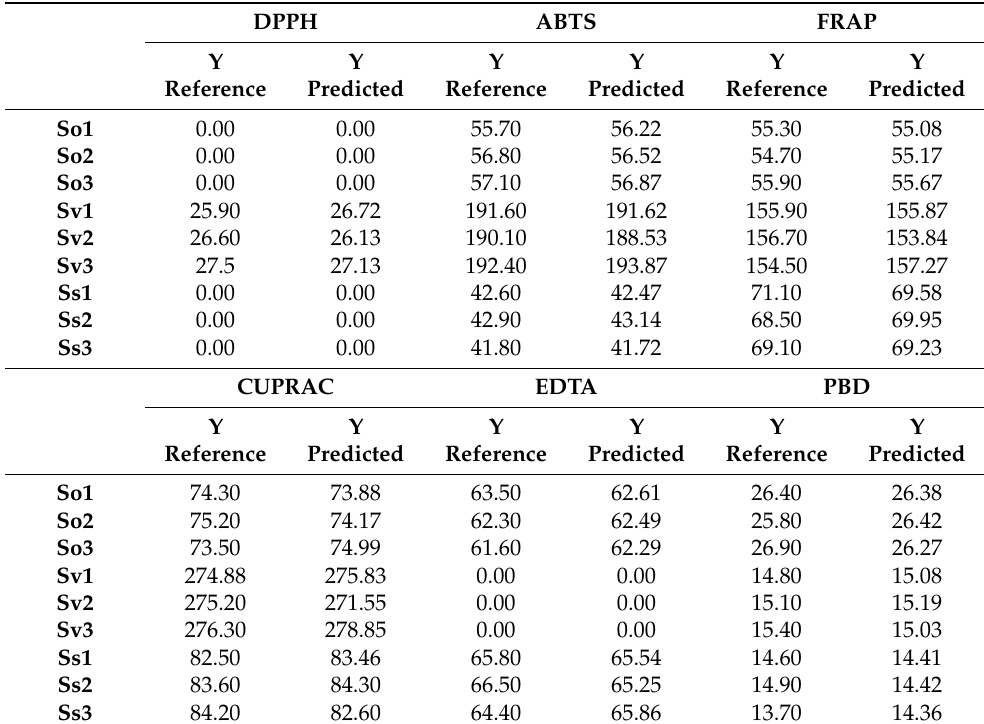
Table 5. Results of calibration and predictive ability of the PLS-R1 model. ( S. officinalis (So), S. virgata (Sv) and S. sclarea